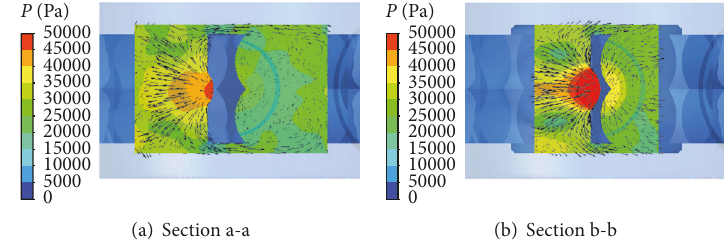
Figure 17: Static pressure distributions and absolute velocity vectors of Blade A ( 𝜃 ∗ = 36 ∘ , 𝑛 = 250 ,000 min −1 ).